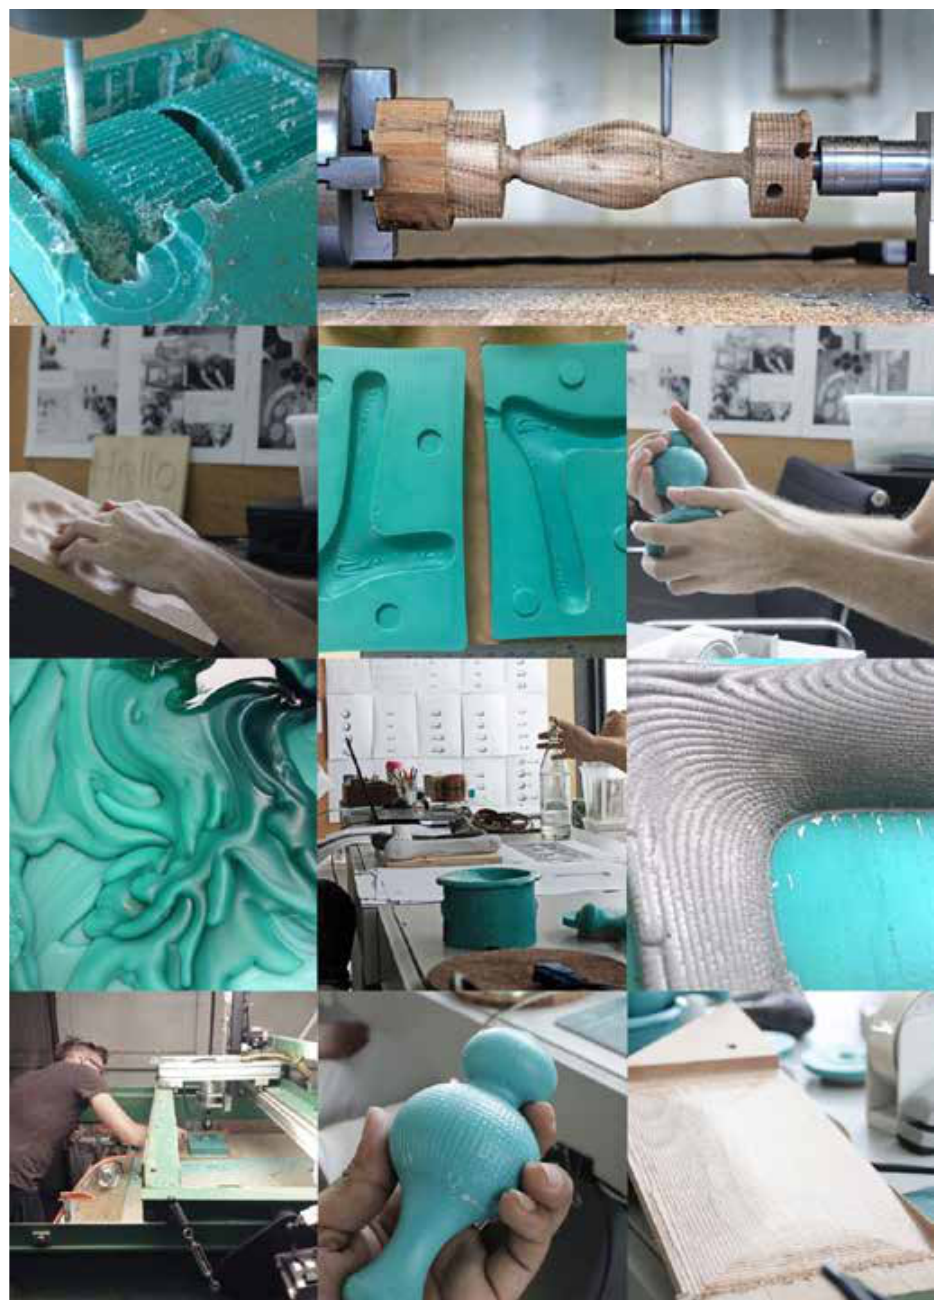
Figure 7: Letting the machines handle the material. We expanded our studio’s CNC capabilities to allow uninhibited experimentations. Moving fluidly from studio to workshop allows failure and discovery to overlap and materialise quicker. We machine directly into wax to create prototypes that can either be cast in metal, or cast aside. Source: